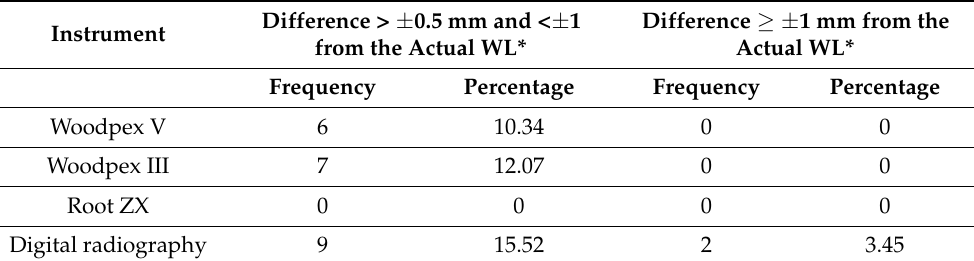
Table 1. Frequency of differences > ± 0.5 mm and > ± 1 mm between the measured values and the actual working length